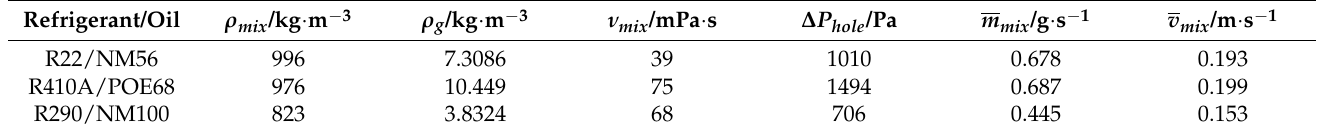
Table 4. Liquid-return characteristics with different refrigerant/oil